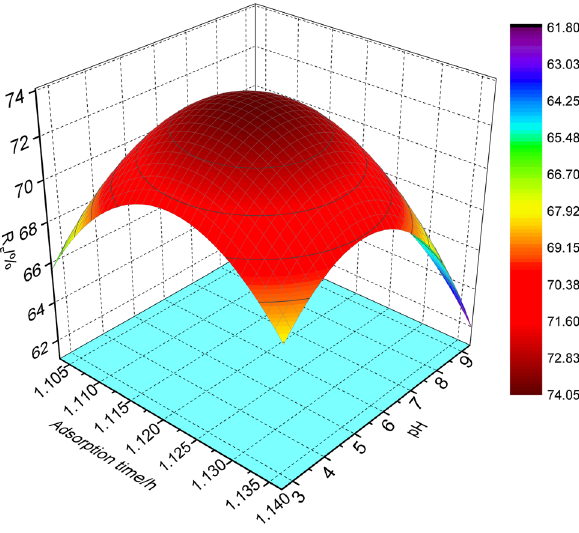
Figure 11: Interaction of adsorption time and solution volume on the response surface.